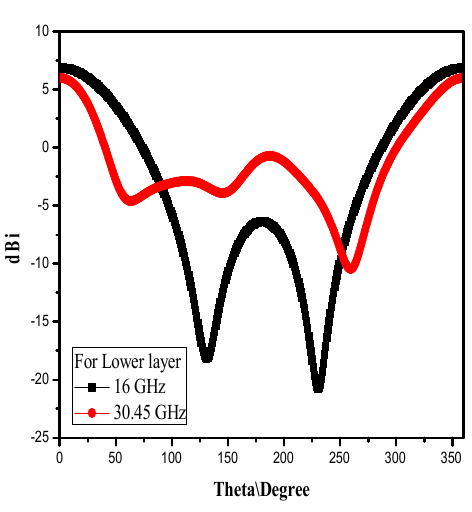
Fig. 6. Gain variation for Lower layer For the final two-layer structure, the antenna is providing a gain of about 7.0 dBi and 7.8 dBi at the two resonating frequencies. The YZ-plane and XZ-plane have been shown in the graphs separately for both resonant frequencies. It can be clearly analyzed from here that the two-layer structure is giving better antenna characteristics which is very essential for high frequency applications. Also the side lobe levels have been reduced to a good extend of around -12 dB at the resonating